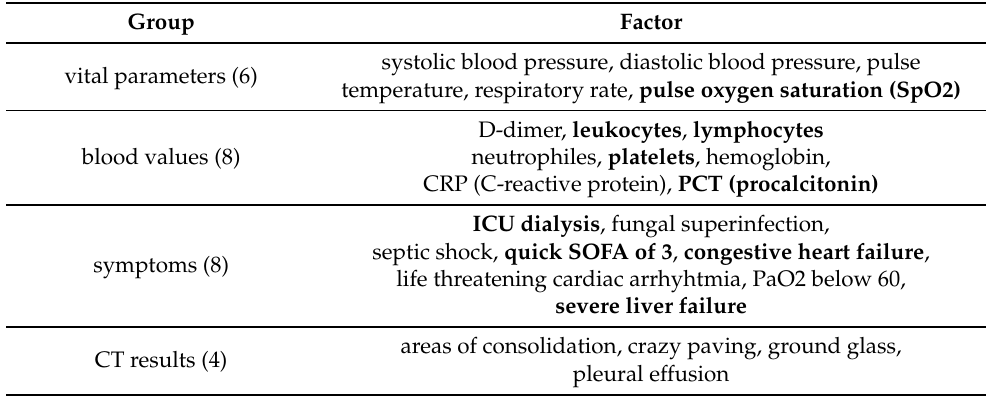
Table 2. Variables measured during the critical phase of the COVID-19 disease. Bold typeface indi- cates that the variable is an independent risk factor in our logistic regression model. PaO2 = partial pressure of oxygen